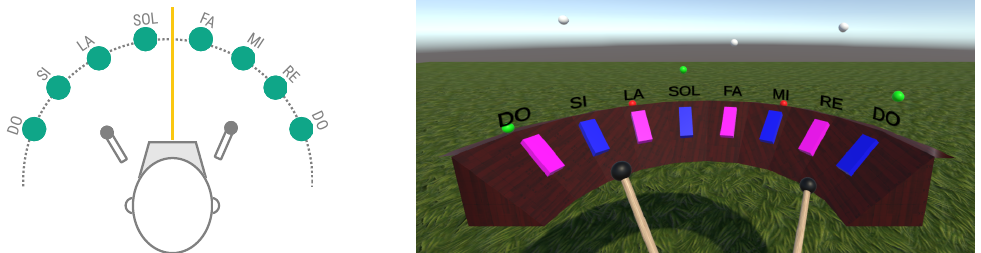
Figure 6. General setup of the symmetrical setup of the Assessment task in schematic ( left ) and virtual environment ( right